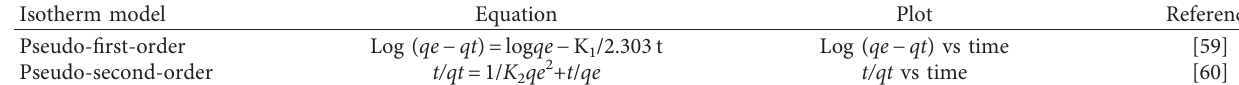
Table 4: Equations for pseudo-first-order and pseudo-second-order kinetic models.